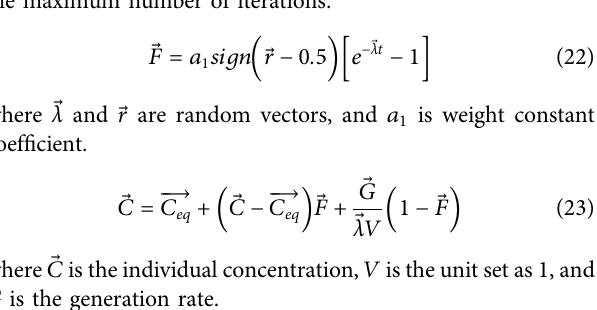
Frontiers in Energy Research |